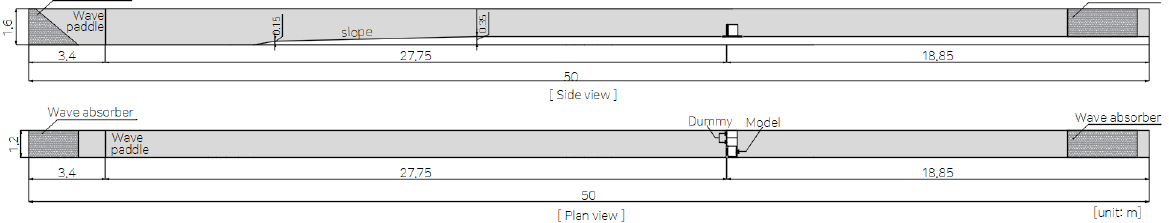
Figure 5. ( a ) Front view and ( b ) side view of the caisson model where the placement of the S-beam load cells is also illustrated. Table 1. Properties of the rubble stones used in the experiments. Type